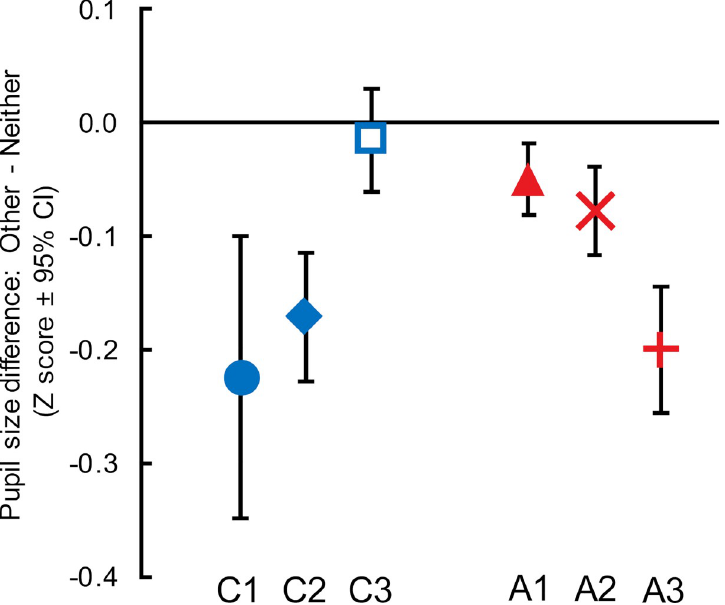
Fig 3. Monkeys without prosocial preferences after ACC lesions still showed pupil size differences on Other versus Neither trials. Difference in mean pupil change from baseline (Z score ± 95% CI) between Other and Neither trials during the 50-ms epoch fixating on the peripheral saccade target prior to juice delivery in Other and Neither trials. Positive values indicate larger pupils on Other trials, and negative values indicate larger pupils on Neither trials. Data are from the final 20 sessions of postoperative acquisition, Social condition only. Control monkeys: C1–C3; monkeys with ACC lesions: A1–A3. See also S3 Fig for the pupil widths in Other and Neither trials that went into this difference score. Underlying data can be found in S2 Data. ACC, anterior cingulate